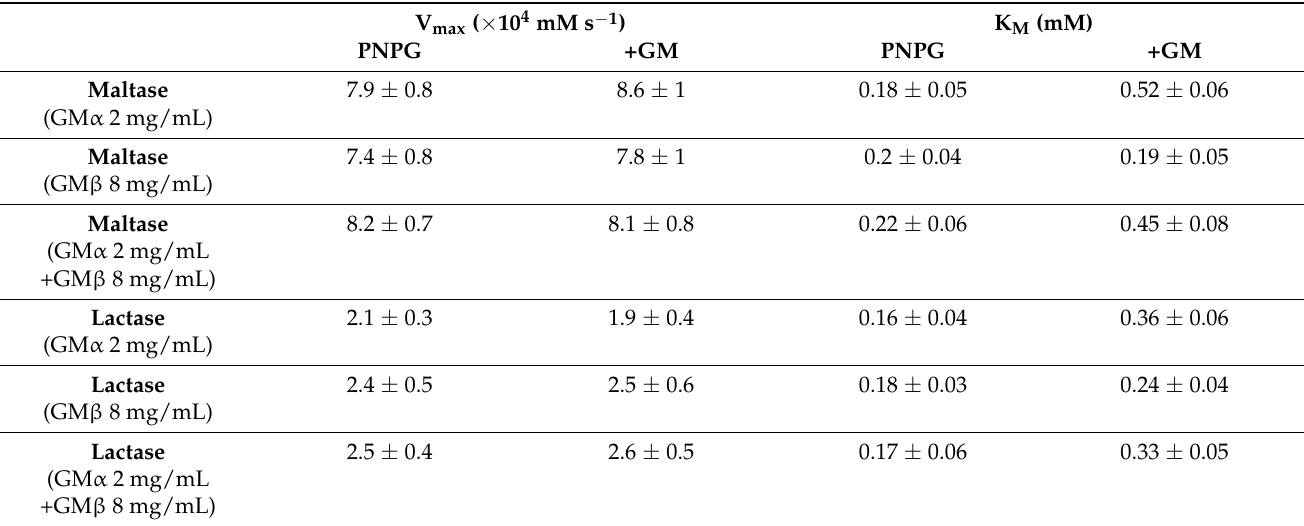
Table 2. Rates of enzyme-mediated hydrolysis of PNPG